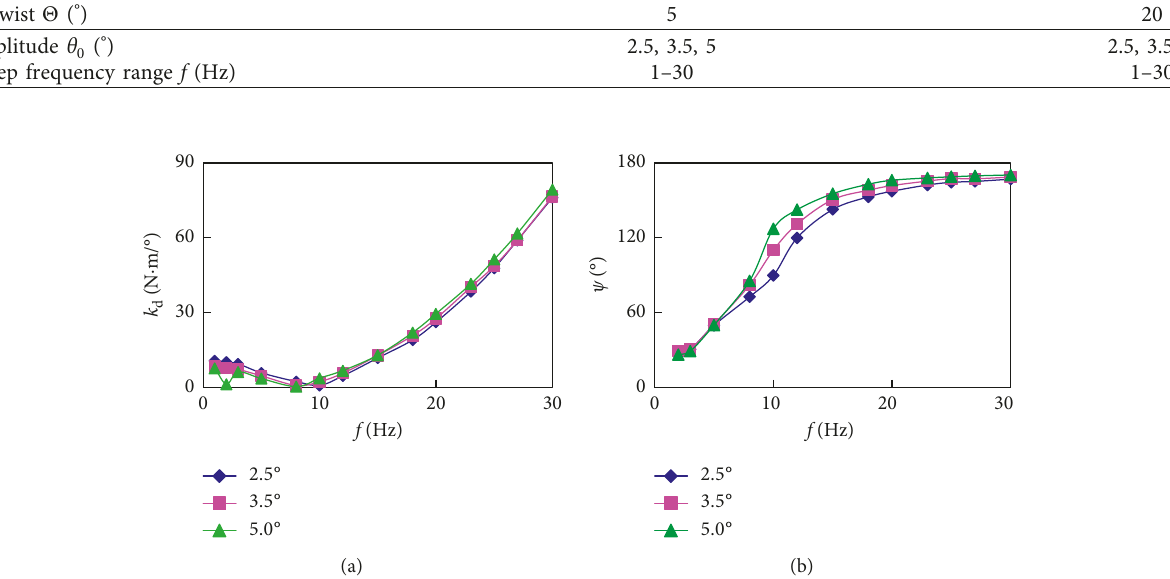
5 ° . (a) Dynamic stiffness k d . (b) Lag angle ψ (cid:31) Θ